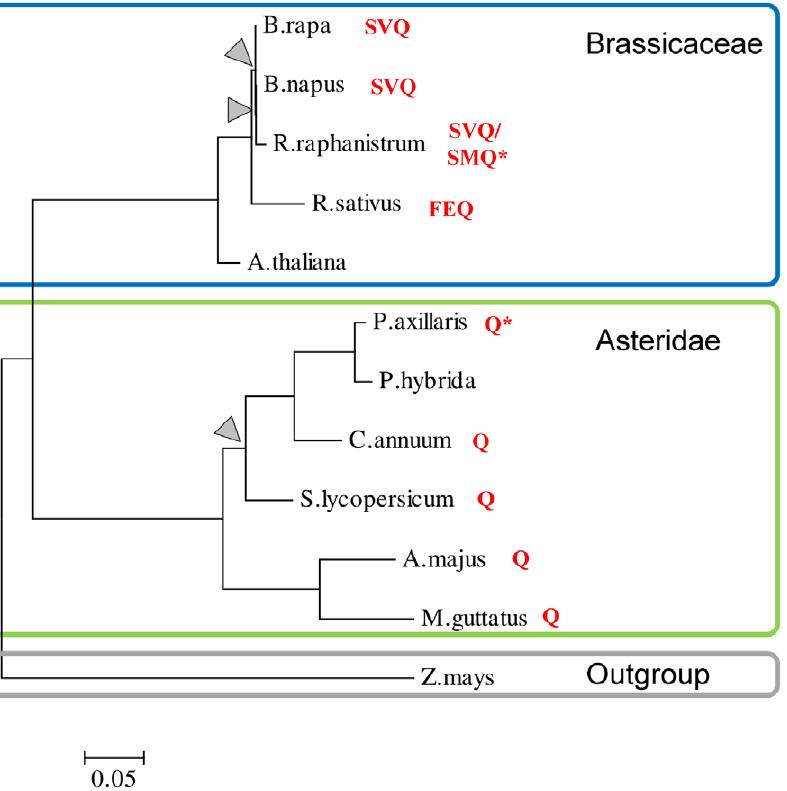
Figure 3. Conservation of AS induced polymorphisms (AIPs) between homologs of the Arabidopsis AGAMOUS (AG) protein. A neighbor-joining tree illustrates the phylogenetic relationship between homologs of the Arabidopsis AG protein. Nodes with less than 70% bootstrap support are indicated with grey triangles. Except for Zea mays , which was included as outgroup species, the taxa within the tree are either members of the Brassicaceae subfamily or the Asteridae class. Residues behind taxon names correspond to the AIP sequence segment and an asterisk indicates that only the inserted residue(s) were found. No insertions were found in Arabidopsis and in P. hybrida . The distinct insertions found in R. raphanistrum might be the result of different allelic variants or sequencing errors. Note that the sequences from the taxa within the Asteridae are homologs of the FARINELLI (FAR) gene in Antirrhinum majus. The full names of the species used in this tree are provided in the Material and Methods section. The alignment corresponding to this tree is provided in Figure S5.